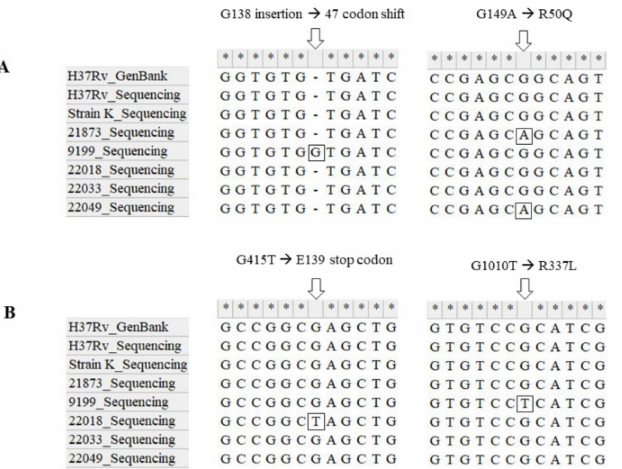
Figure 3. CFZ resistance-related gene mutation sites and related isolates and reference strains. ( A ) Rv0678 gene; ( B ) pepQ gene. The mutation site has been shown with white arrows and squares. The prediction of amino-acid transition has been shown on the gene mutation site. H37Rv and K were used as a reference for